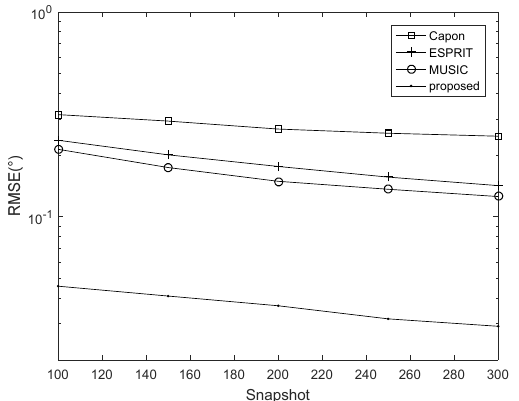
Figure 13. RMSE performance of different algorithms versus the number of snapshots.